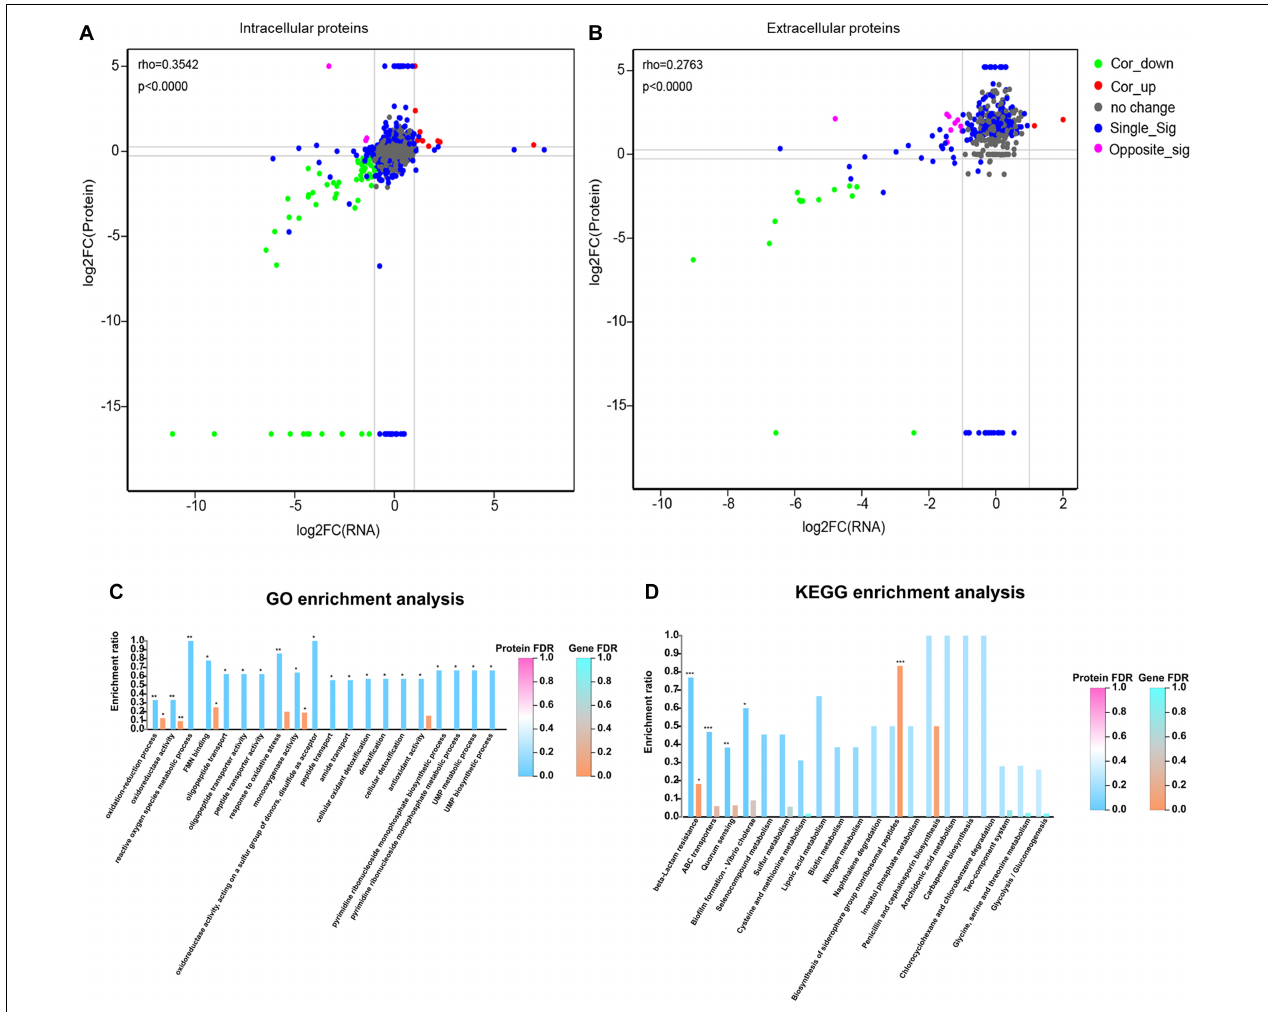
FIGURE 5 | Integrated analysis of the RNA-seq and label-free MS data for comparisons of the mutant and reference strains. (A,B) Correlation analysis between the RNA-seq and MS data for intracellular and extracellular protein fractions, respectively. In the nine-quadrant diagram, green (Cor_down) represents downregulated genes and proteins, red (Cor_up) represents upregulated genes and proteins, gray (no change) represents genes and proteins with no significant difference, blue (Single_Sig) represents one of the genes and proteins with no significant difference, purple (Opposite_Sig) indicates that DEGs and DEPs show opposite upregulation and downregulation. (C) Integrated GO term enrichment analysis of DEGs and DEPs for the intracellular protein fraction. (D) Integrated KEGG pathway enrichment analysis of DEGs and DEPs for the intracellular protein fraction. *FDR < 0.05, **FDR < 0.01, ***FDR <